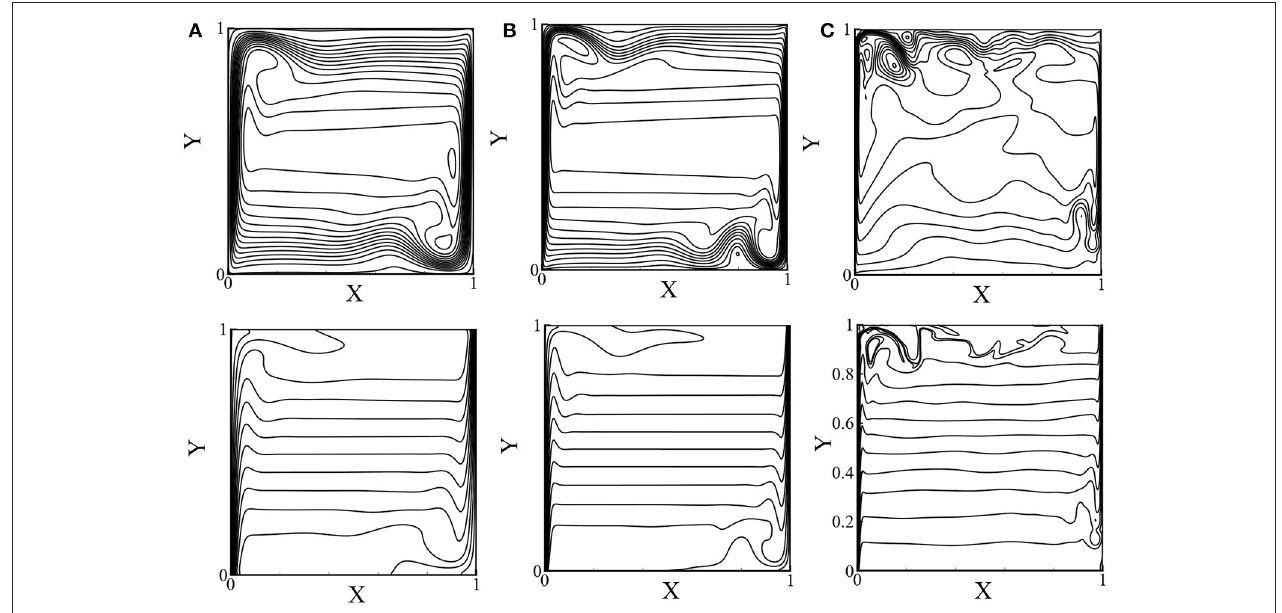
FIGURE 7 | Streamlines (top) and isotherms (bottom) for pure fluids for Pr